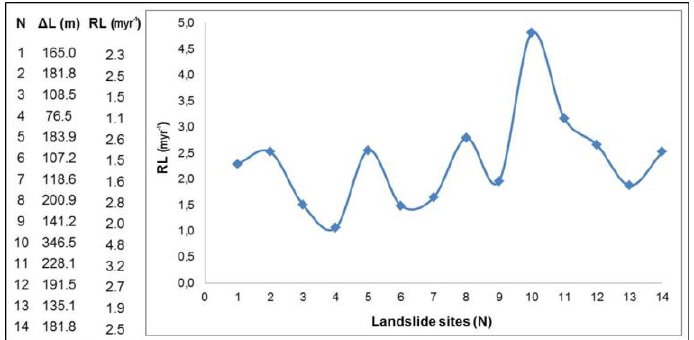
Figure 13. The table and the chart illustrate the results of estimated RL for each landslide site in the Santomerion area from 1945–2017.